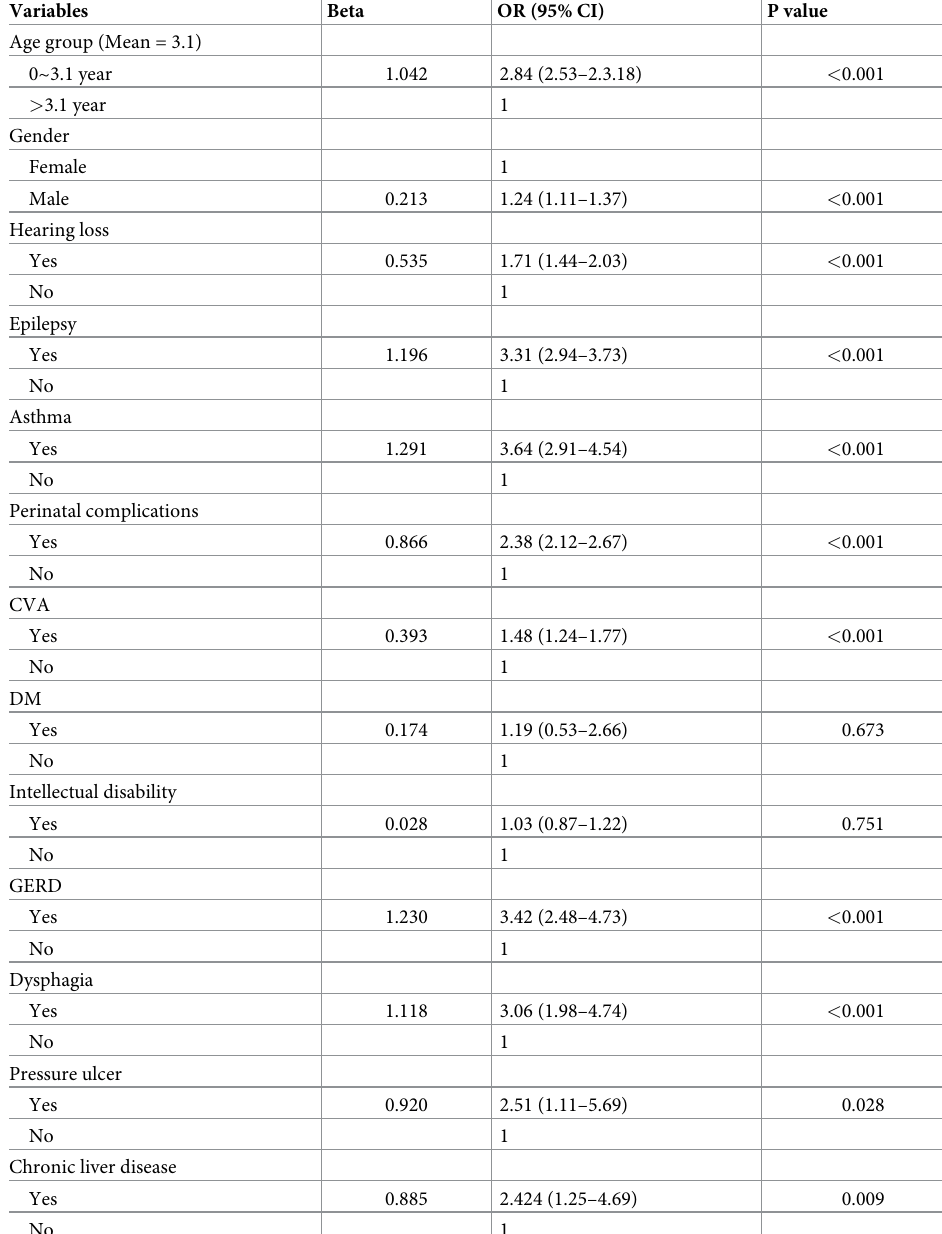
Table 2. Univariate logistic regression analysis for severe pneumonia among children and young people with severe cerebral palsy with � 5 days inpatient care and none, n = 5134. Variables